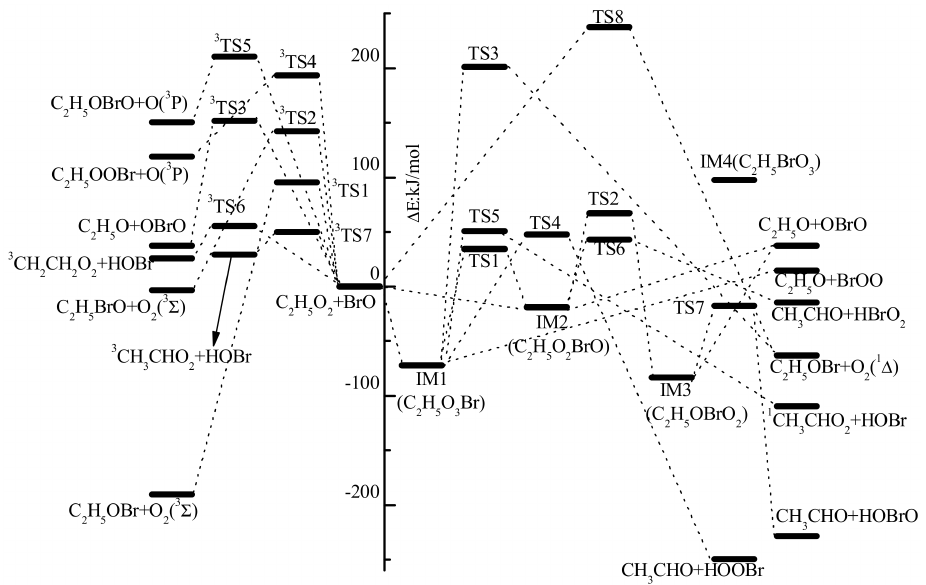
Figure 2. Energetic profiles of the C 2 H 5 O 2 + BrO reaction at the QCISD(T)/6-311++G(2df,2p)// B3LYP/6-311++G(2df,2p)